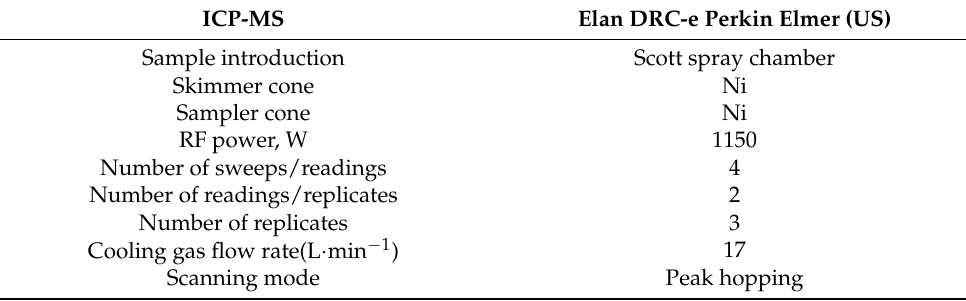
Table 3. The adjusted operational requirements of an applied ICP-MS